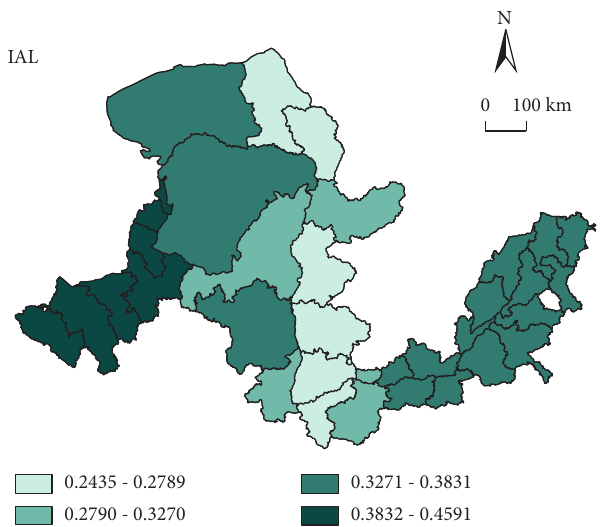
Figure 8: Spatial distribution of regression coefficient of the IAL on